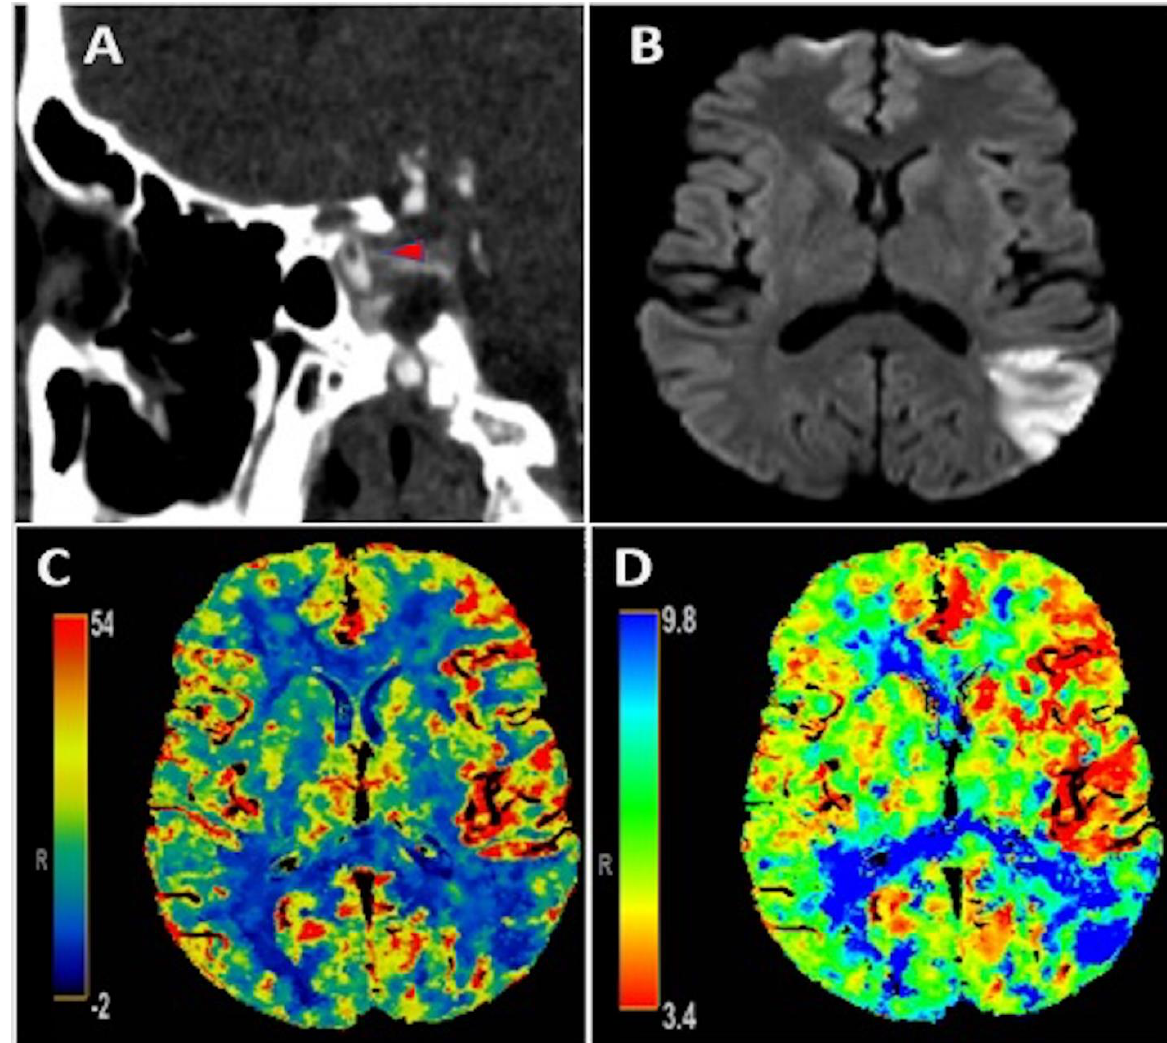
Figure 1. Panel ( A ): CT angiography showing an intraluminal free-floating thrombus (red arrowhead) in the clinoid portion of the left internal carotid artery; Panel ( B ): MRI brain diffusion weighted imaging illustrating an acute ischemic stroke in the posterior left middle cerebral artery (MCA) territory. Panels ( C ) and ( D ): CT perfusion depicting increased CBF and decreased Tmax, respectively, in the anterior left MCA territory consistent with hyperperfusion in this area as well as decreased CBF and increased Tmax in the posterior left MCA territory consistent with core infarction and corresponding with ischemic stroke seen on MRI brain in Panel ( B ).